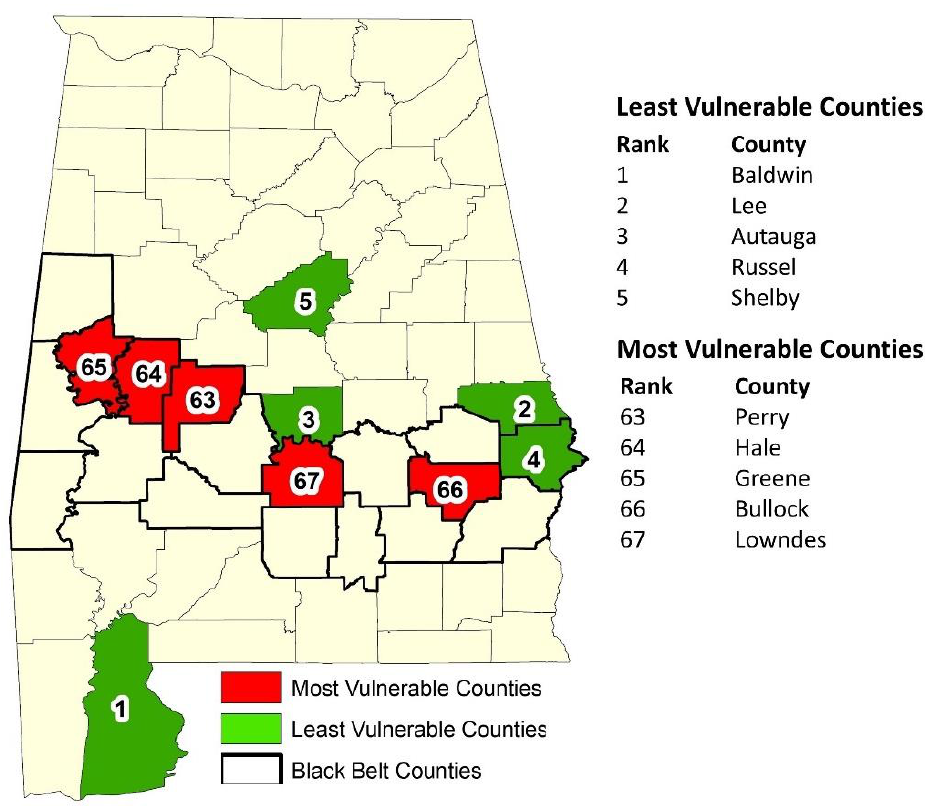
Figure 9. Ranking and location of the five least and most vulnerable counties. Table 7. Correlation between subindices and the COVID-19 Vulnerability